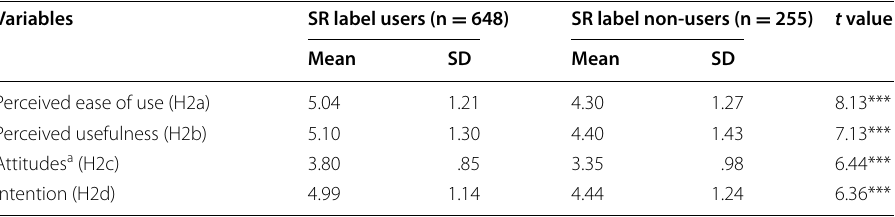
*** p < .001; all variables but a were measured on a 7-point Likert scale; a were measured on a 5-point differential semantic scale